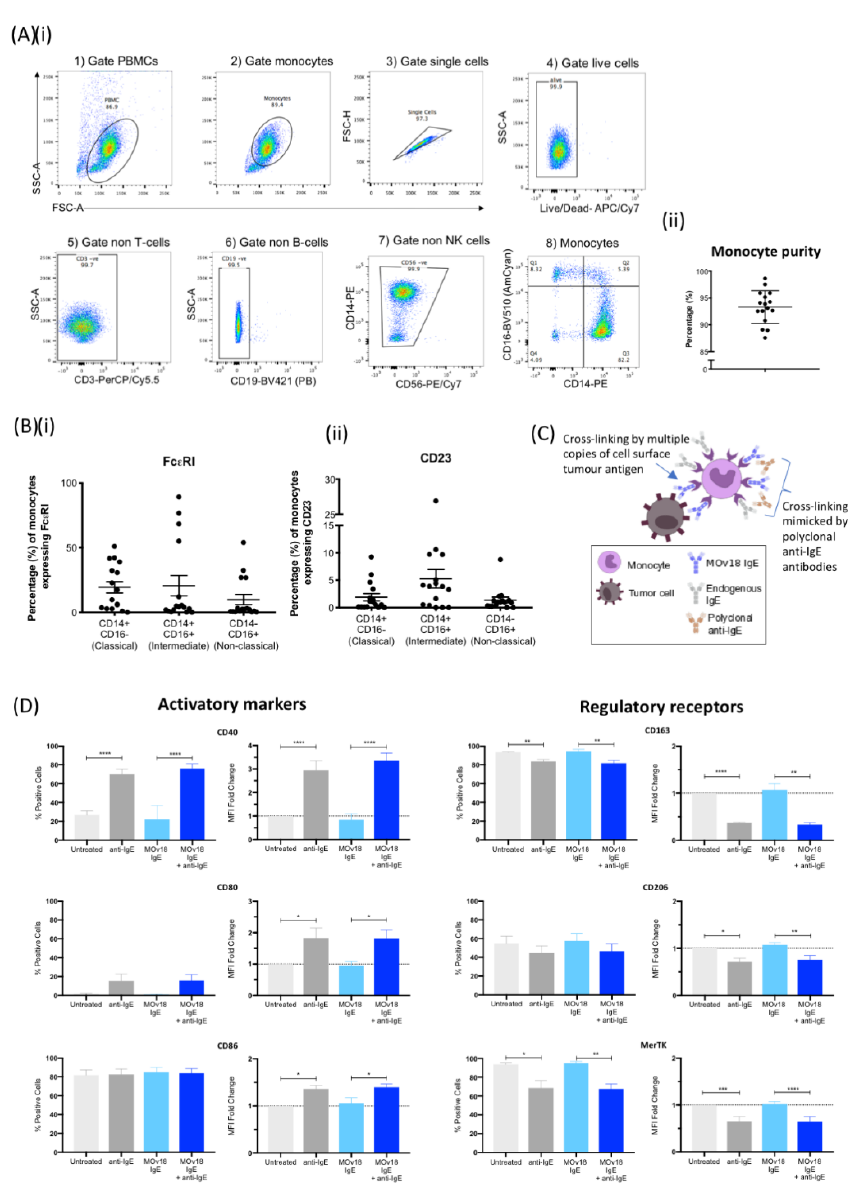
Figure 1. IgE cross-linking on the surface of monocytes triggers upregulation of pro-inflammatory cell surface marker expression and downregulation of regulatory cell surface marker